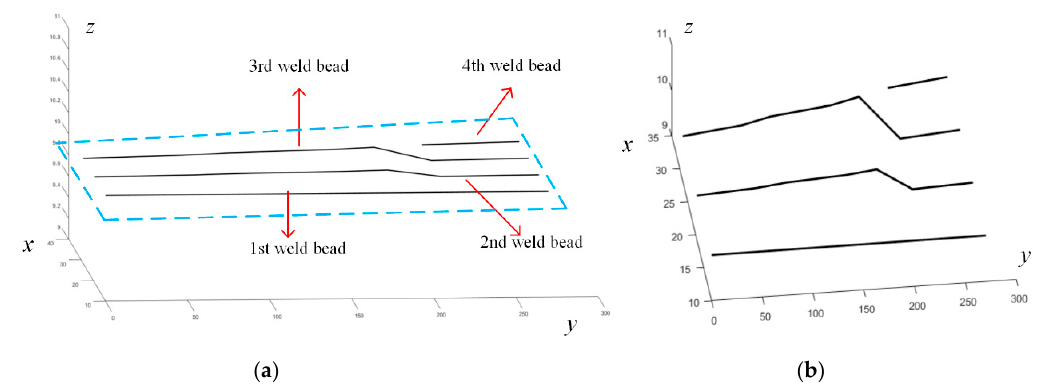
Figure 19. ( a ) Simulation results of the first layer welding path (the blue part is the groove outline); ( b ) Simulation results in a different angle.